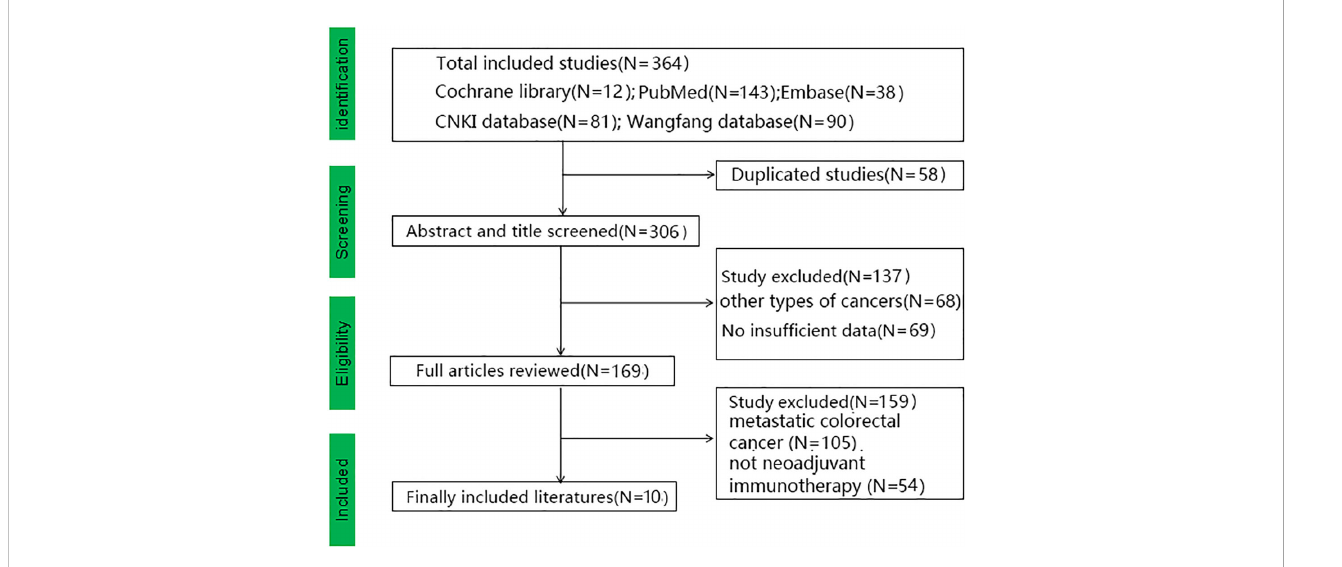
FIGURE 1 Study selection followed by PRISMA